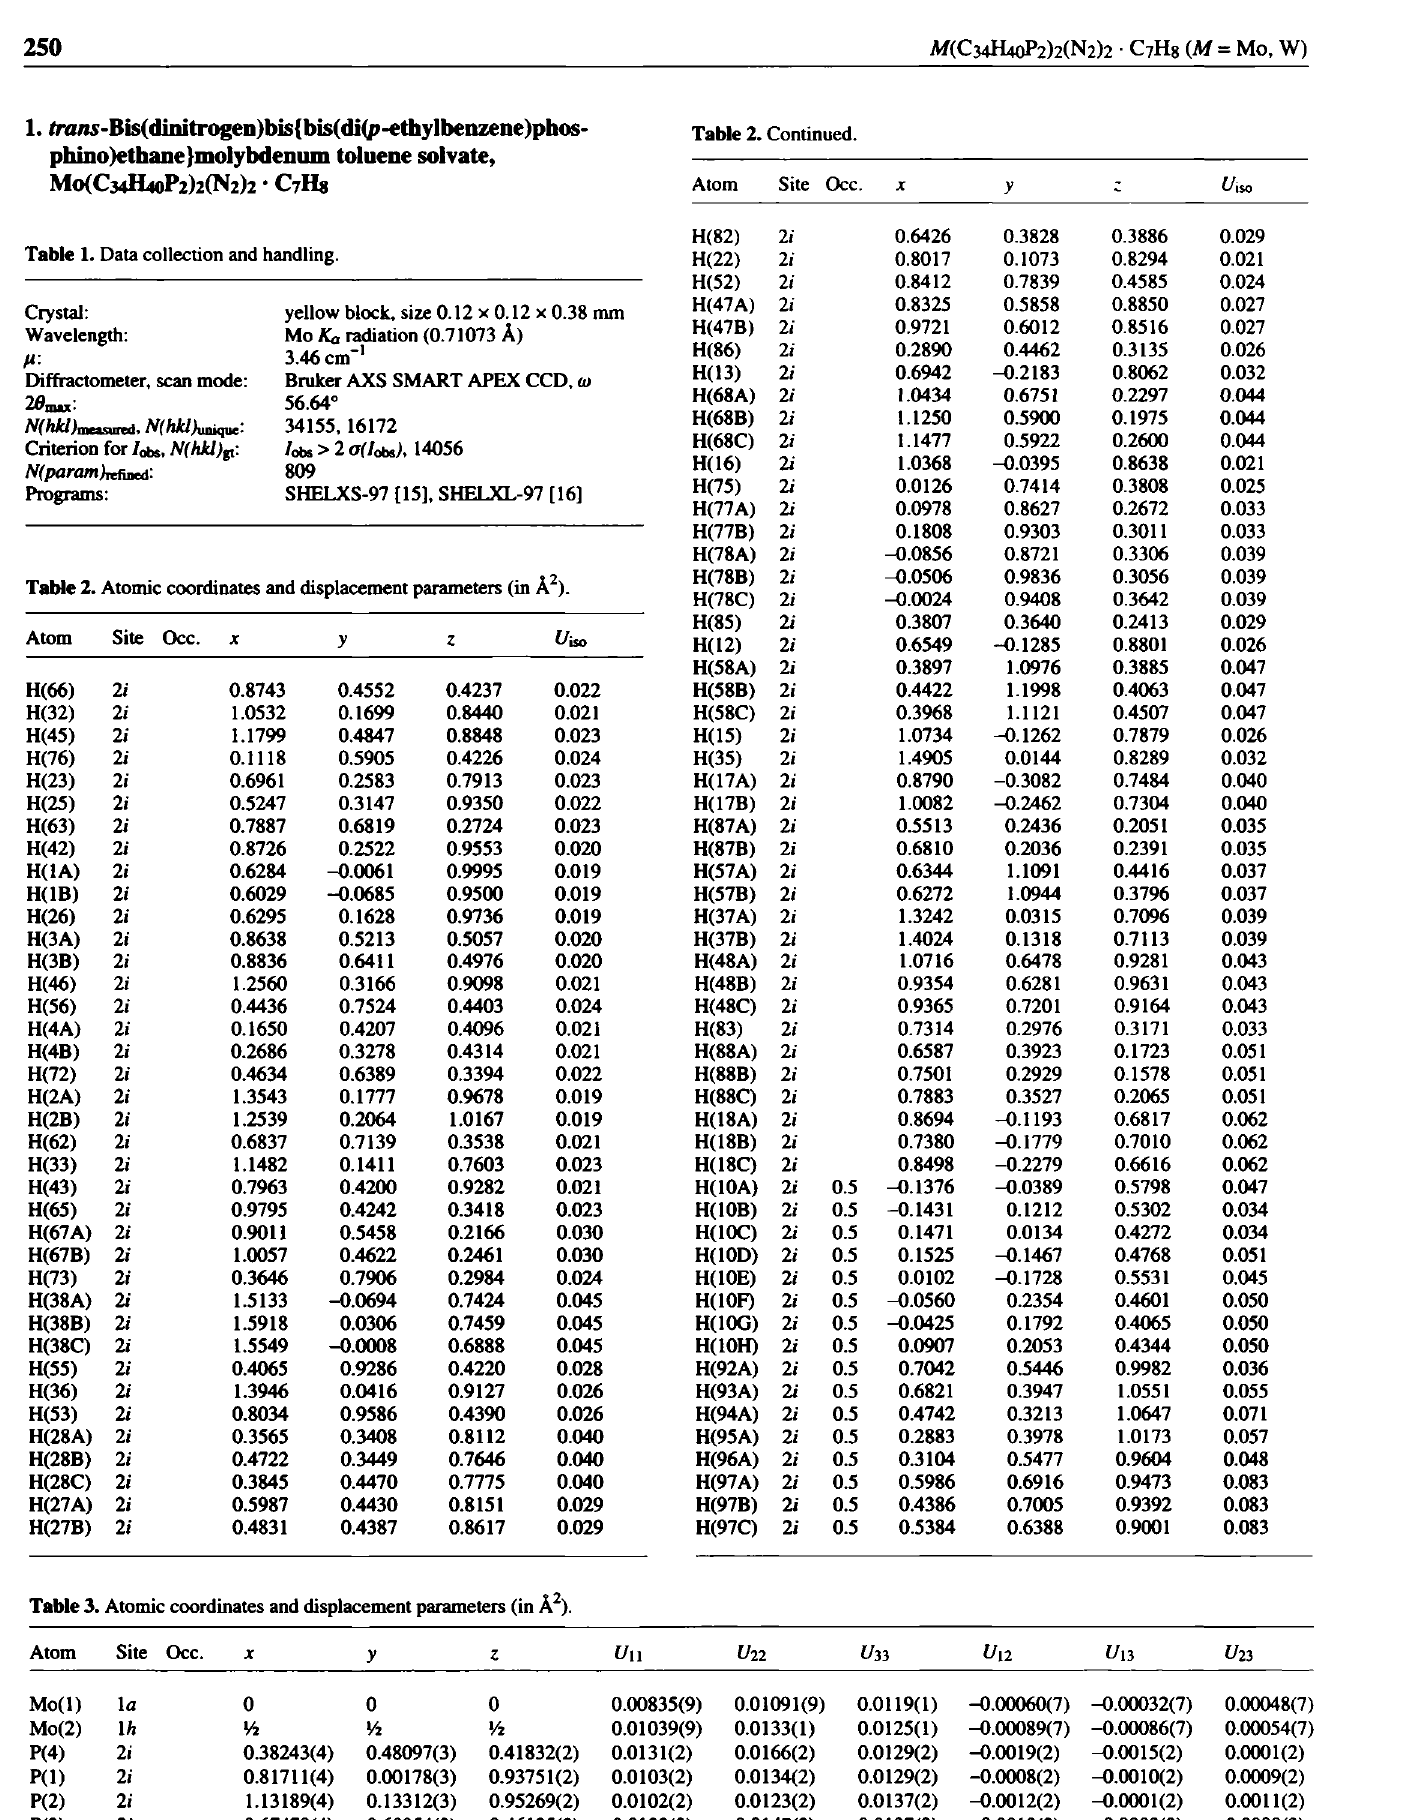
Table 3. Atomic coordinates and displacement parameters (in Â 2